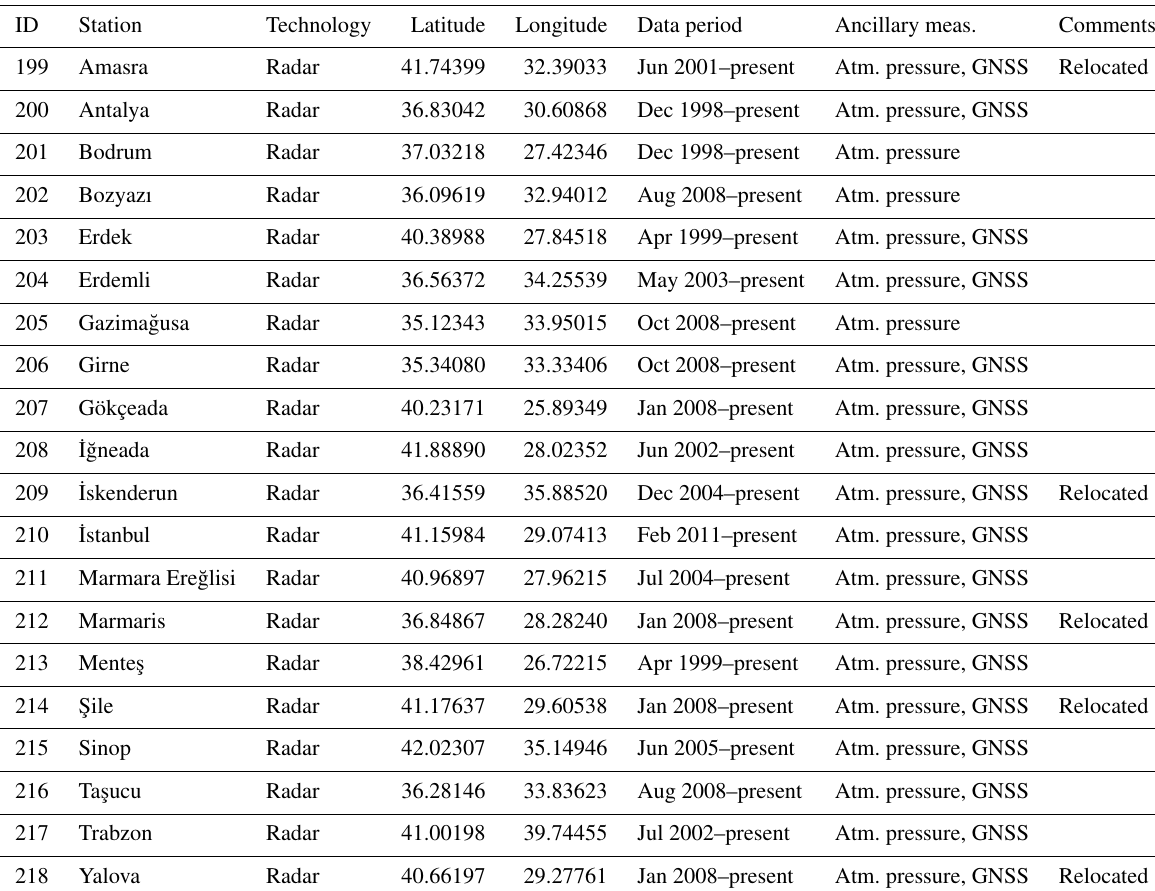
Table A21. Turkish Sea Level Monitoring System (TUDES) tide gauge stations operated by the General Directorate of Mapping and data availability.